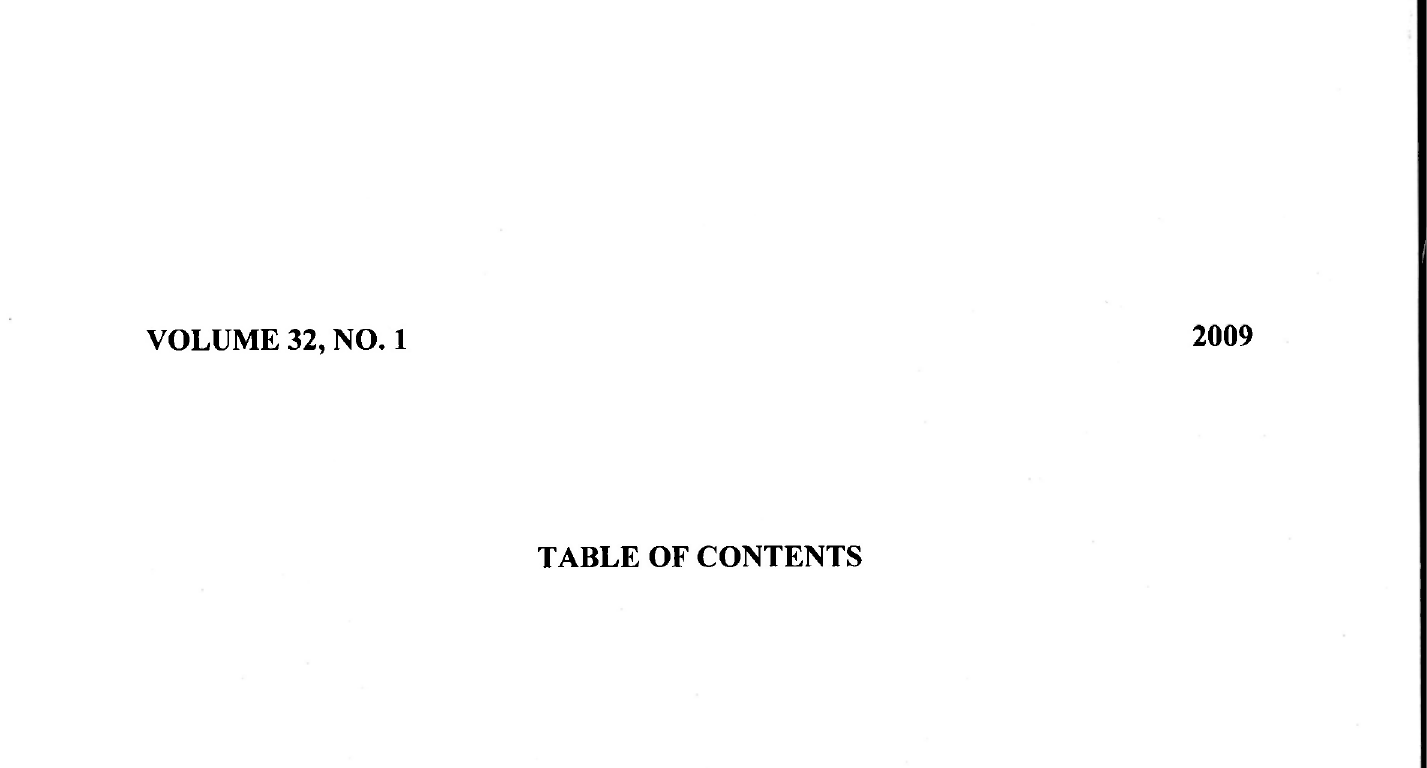
Isomers of Organotin Compounds II.Di- to Polymeric Compounds Milan Melnik, Jan Garaj, Aladar Valent and Maria Kohutova 1 The Bio Side of 9,10-Diaminophenanthrene Derivatives of Bivalent Tin: Synthetic Route, Spectroscopic Characterization and Applied Aspects with Toxicological